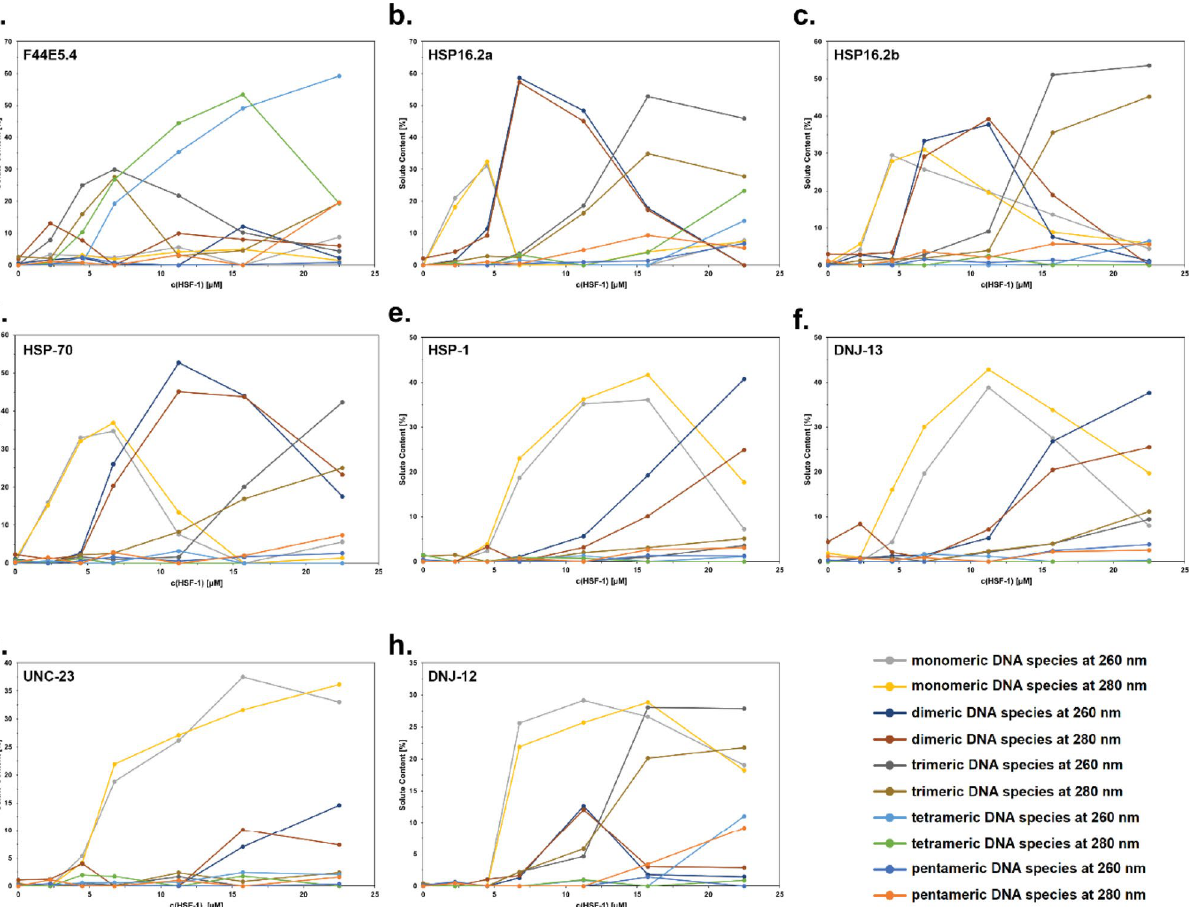
Figure 6. Partial concentration of each species in DNA-HSF-1 samples, derived via custom grid fitting. Selected promoter = ( a ) F44E5.4; ( b ) HSP16.2a; ( c ) HSP16.2b; ( d ) HSP-70; ( e ) HSP-1; ( f ) DNJ-13; ( g ) UNC-23; ( h ) DNJ-